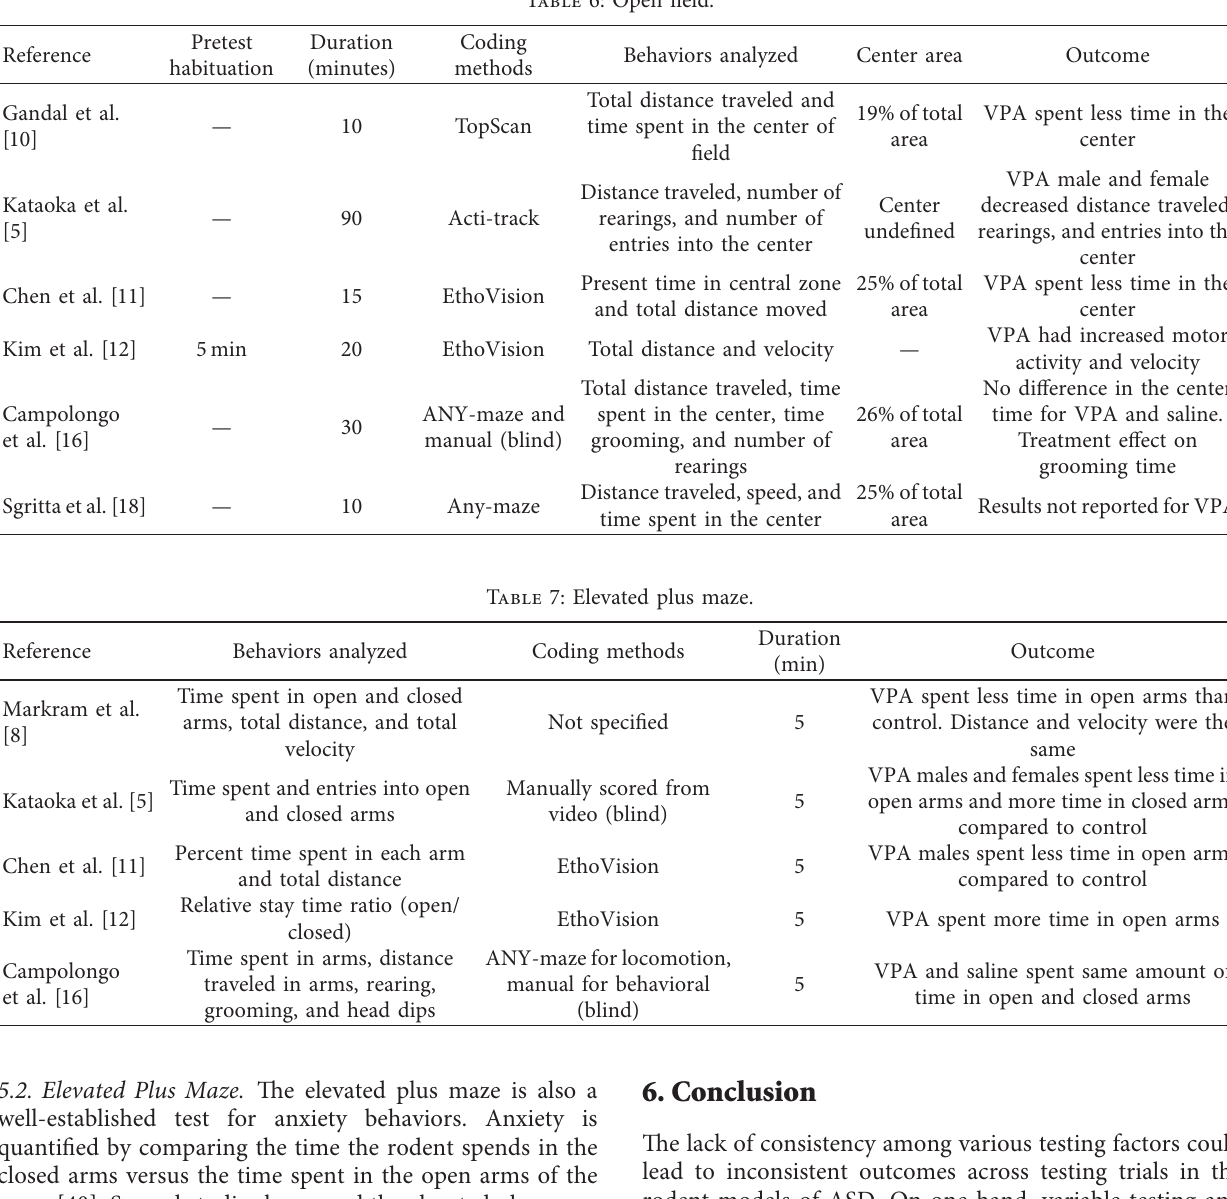
Table 6: Open field.